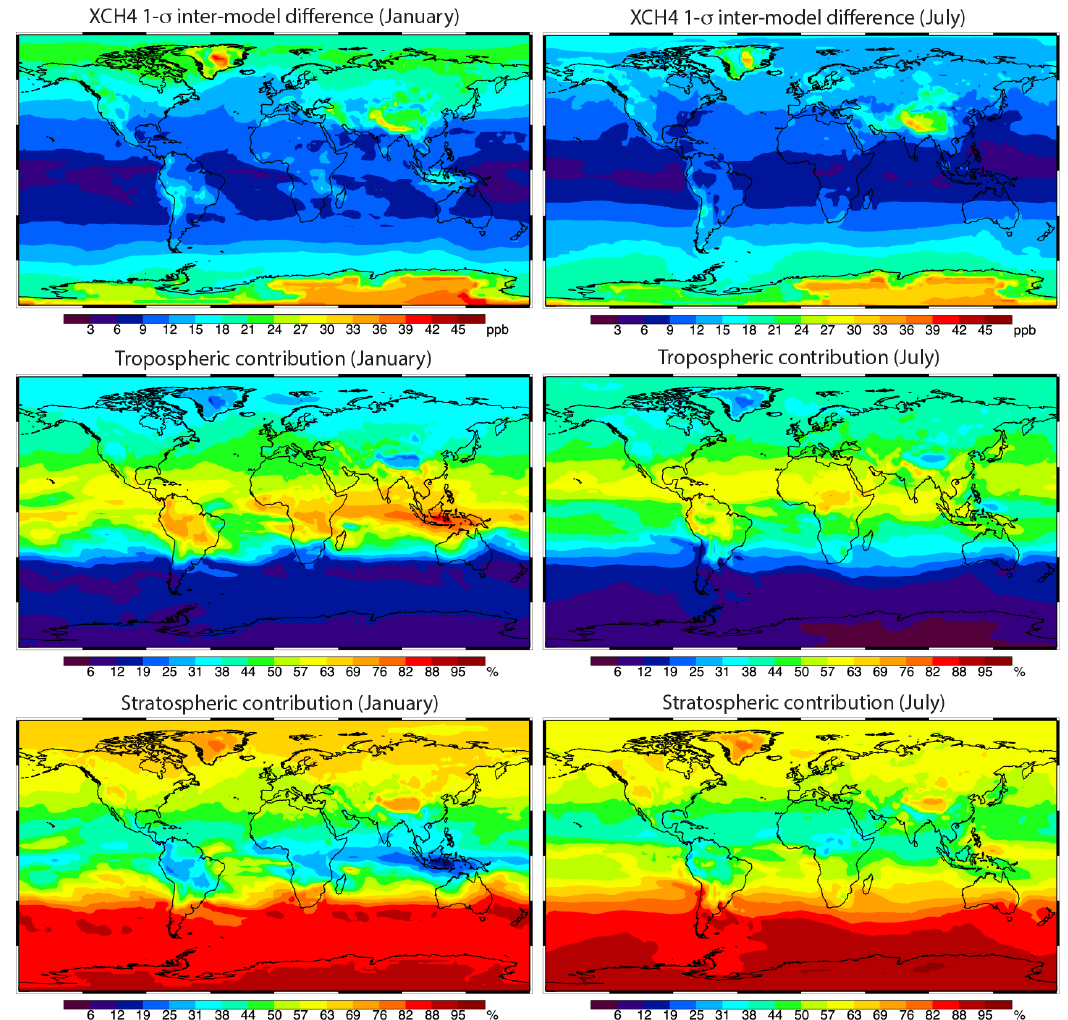
Figure 3. Uncertainty in XCH 4 due to transport model differences for January (left) and July (right). The middle and bottom panels show the percent contribution from the troposphere (1000–200hPa) and the stratosphere (200–0hPa) to the total column variability shown in the top panel. Results are obtained using the submissions to the TransCom-CH 4 experiment (Patra et al., 2011) (Control (CTL) tracer for the year